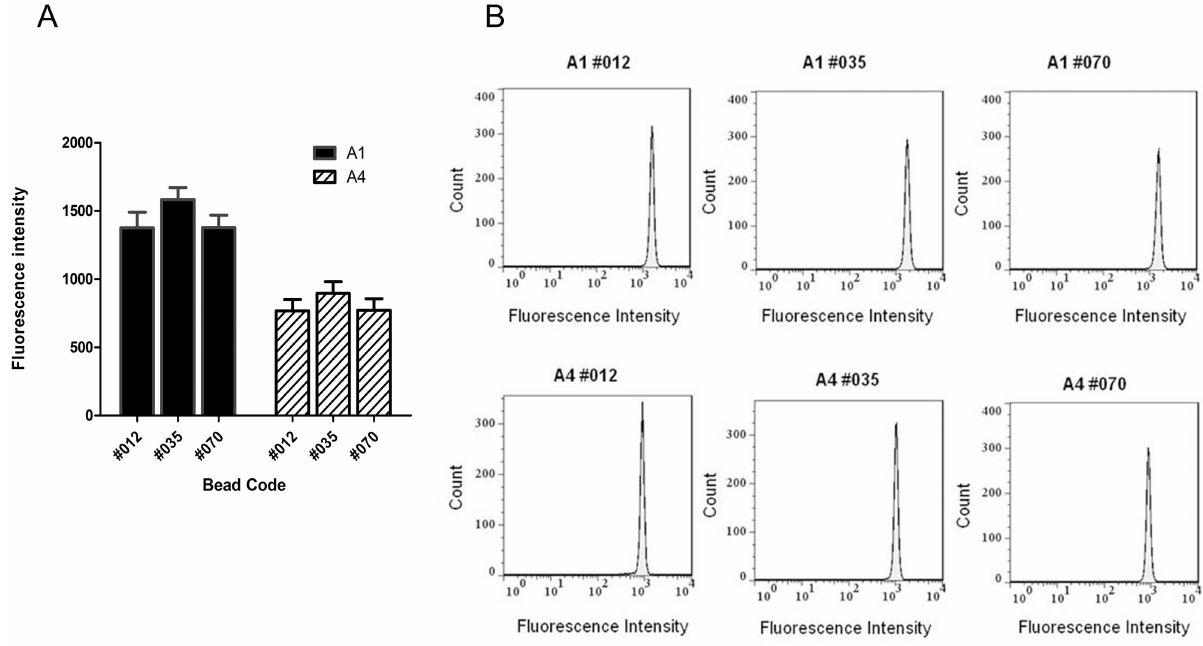
Fig 1. Evaluation of different codes of microspheres (#012, #035 and #070). A: Microspheres (#012, #035 and #070) coupledwith 5 μ g/ mL of A1 (black bars) and A4 (dashedbars) conjugates. Fluorescence intensity representedby the means of three geometric means ± standarddeviation.B: Representative histograms of one experiment.PE-fluorescence intensity (X axis) vs. count (Y axis). One way ANOVA was performed for group comparisonand significantdifferences were observedamong all groups (p (cid:20) 0.05).